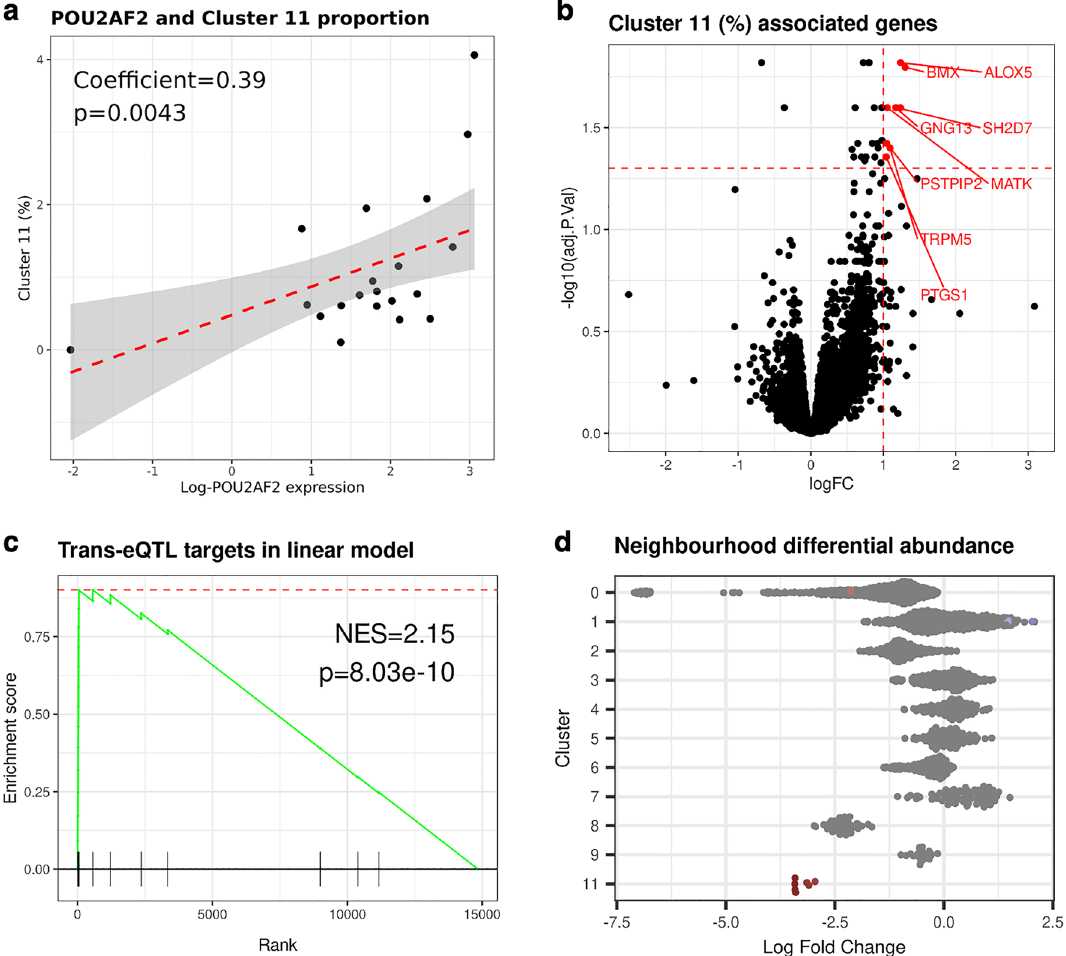
Figure 5. 11q23.1 trans-eQTL target expression is associated with the abundance of tuft cell-like cluster. ( a ) Linear modelling of pseudo-bulked POU2AF2 expression and cluster 11 abundance. ( b ) Volcano plot of linear model result on pseudo-bulked expression of all 14,843 genes. Significantly associated 11q23.1 trans- eQTLs (logFC > 1, FDR < 0.05) highlighted. ( c ) GSEA of 11q23.1 trans-eQTLs (FDR < 0.05) in ( b ), ranked by logFC. ( d ) Differential abundance of neighbourhoods in the ‘Low’ blue hub gene group compared to ‘High’. Neighbourhoods were identified using miloR 26 and grouped by cluster. Only neighbourhoods with major cluster proportion > 0.8 are plotted and only significant neighbourhoods (Spatial FDR < 0.01) are coloured by their logFC (red = down, blue = up). No neighbourhoods from cluster 10 were comprised of major proportion >